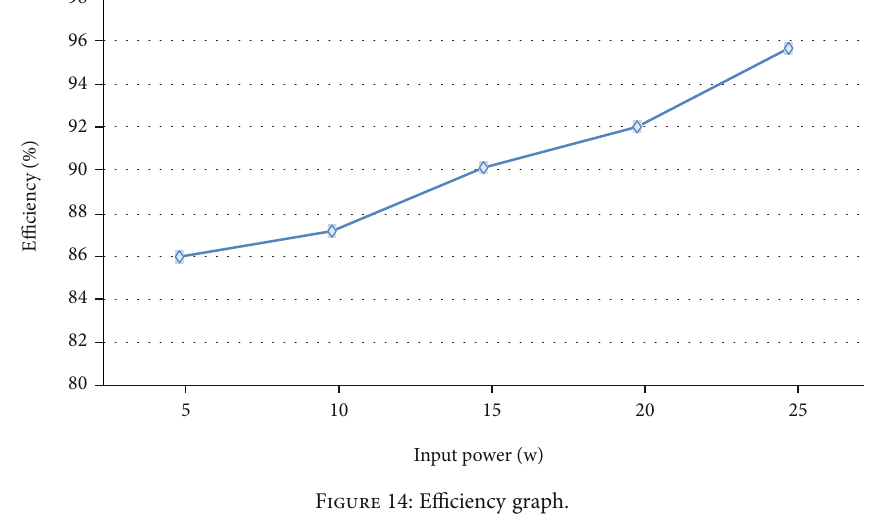
Figure 14: E ffi ciency graph.